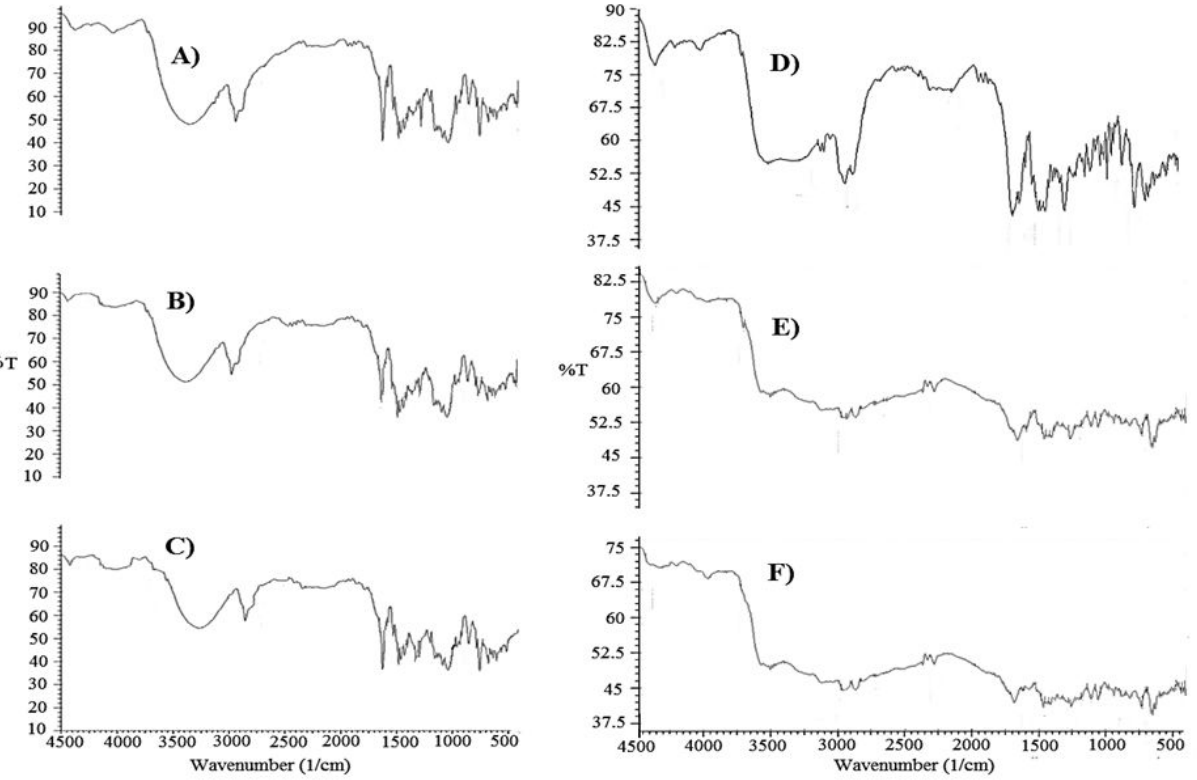
FIGURE 5.2 - FTIR spectra of a) OND-HPβCD 1:1 binary complex; b) OND-HPβCD 1:3 binary complex; c) OND-HPβCD 1:5 binary complex d) OND-PVP K-30 1:1 binary complex; e) OND-PVP K-30 1:3 binary complex; f) OND-PVP K-30 1:5 binary